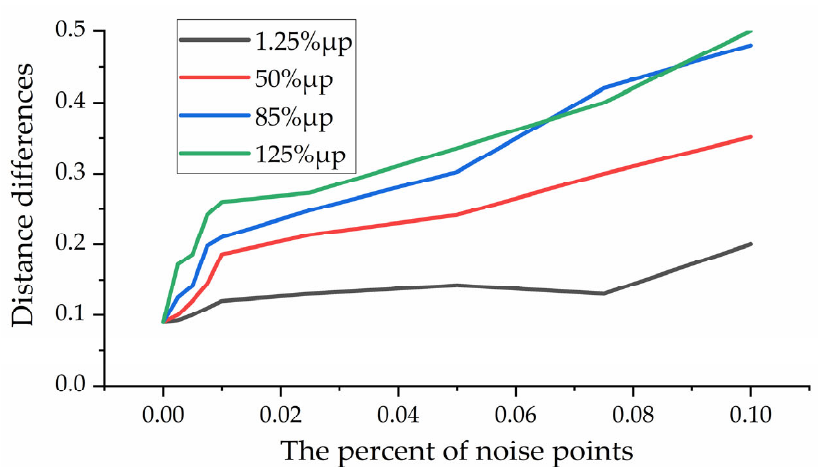
Figure 9. Noise robustness analysis.